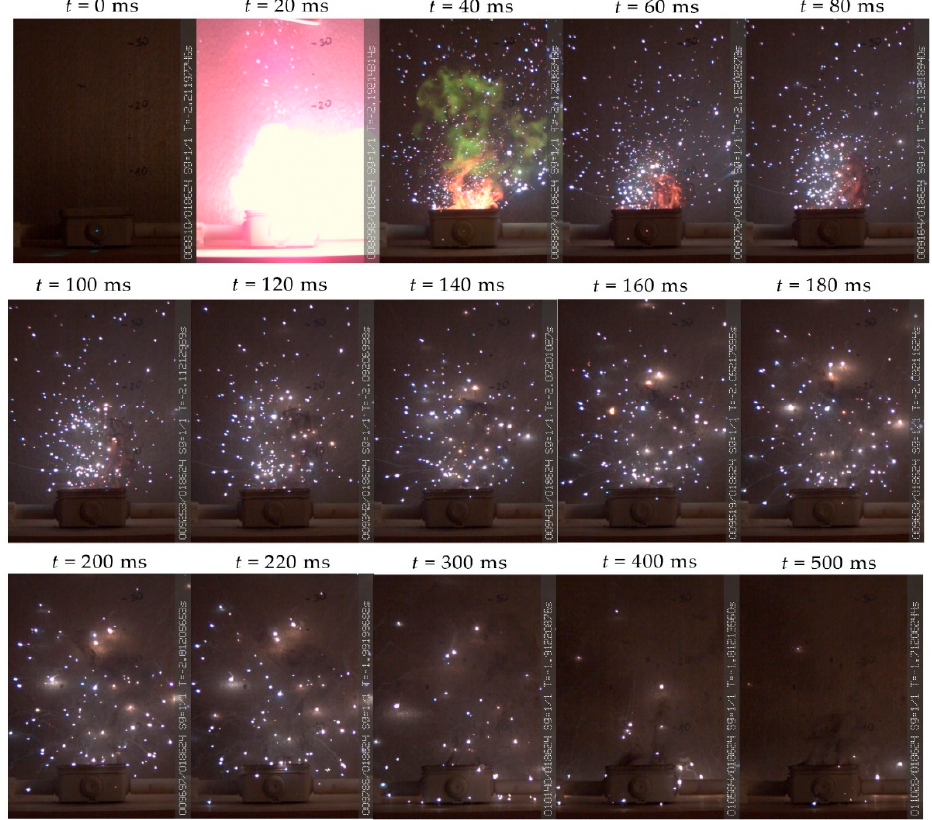
Figure 10. Selected frames of recording the effects of an emergency arc from its ignition to the almost complete extinction of the exploding, glowing remains of drops of electrode material ( I m = 1250 A, U = 400 V, Al-Al electrodes).